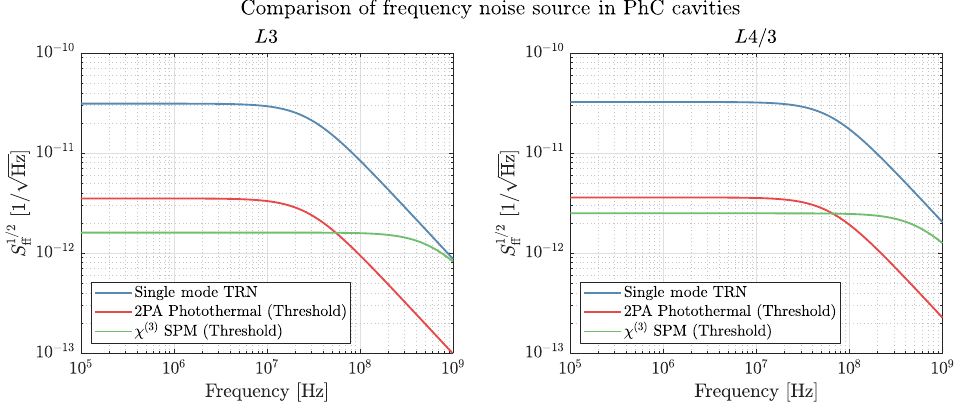
is plotted as a ff